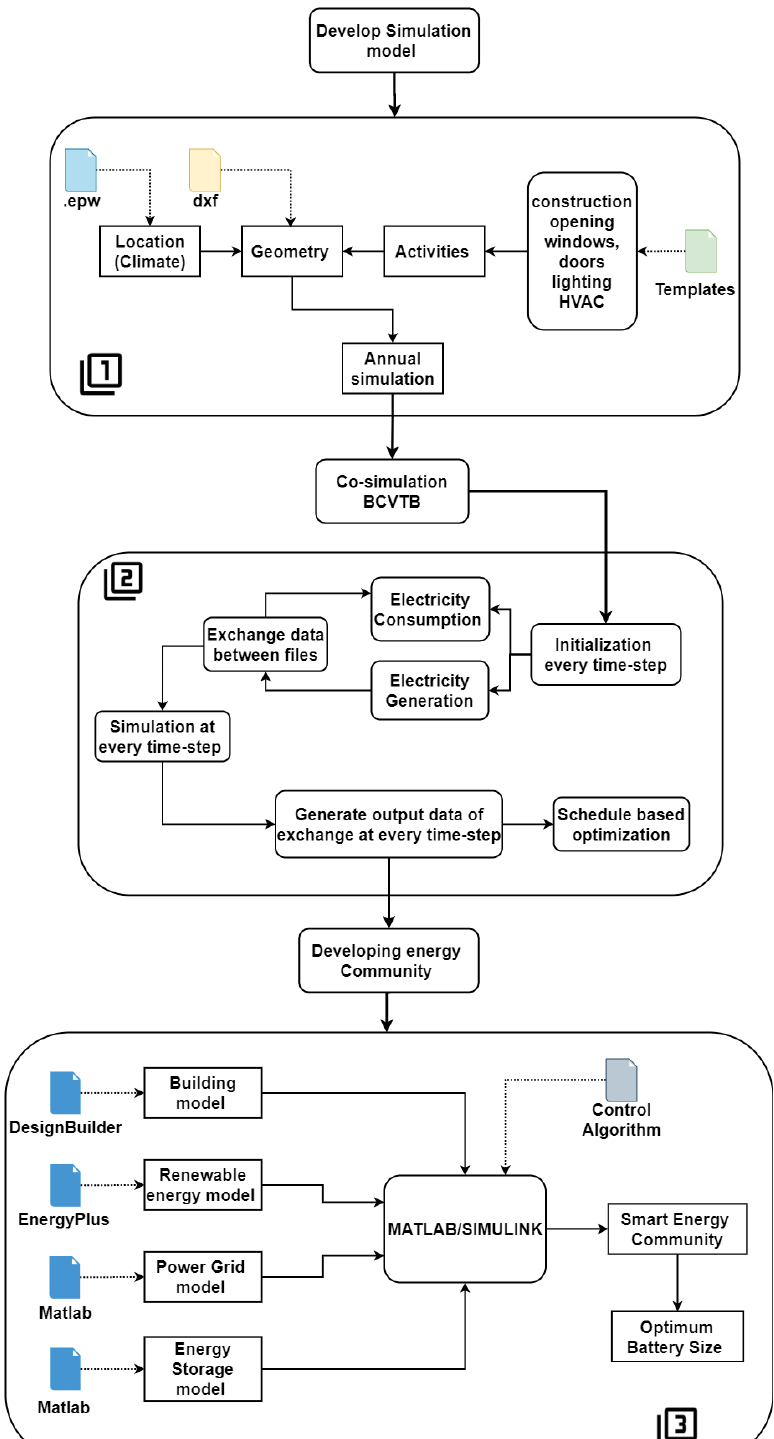
Figure 2. The proposed methodology for a smart energy community.